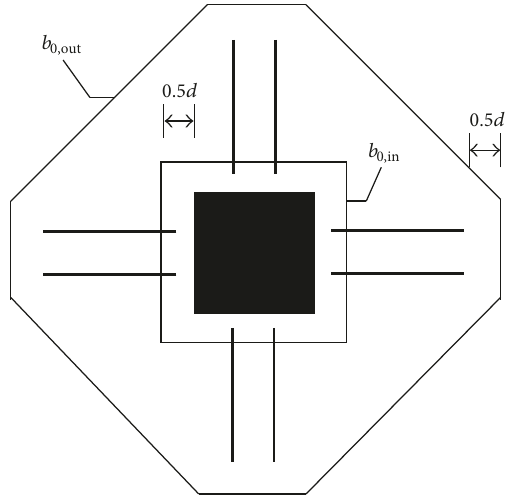
Figure 4: Critical sections according to ACI